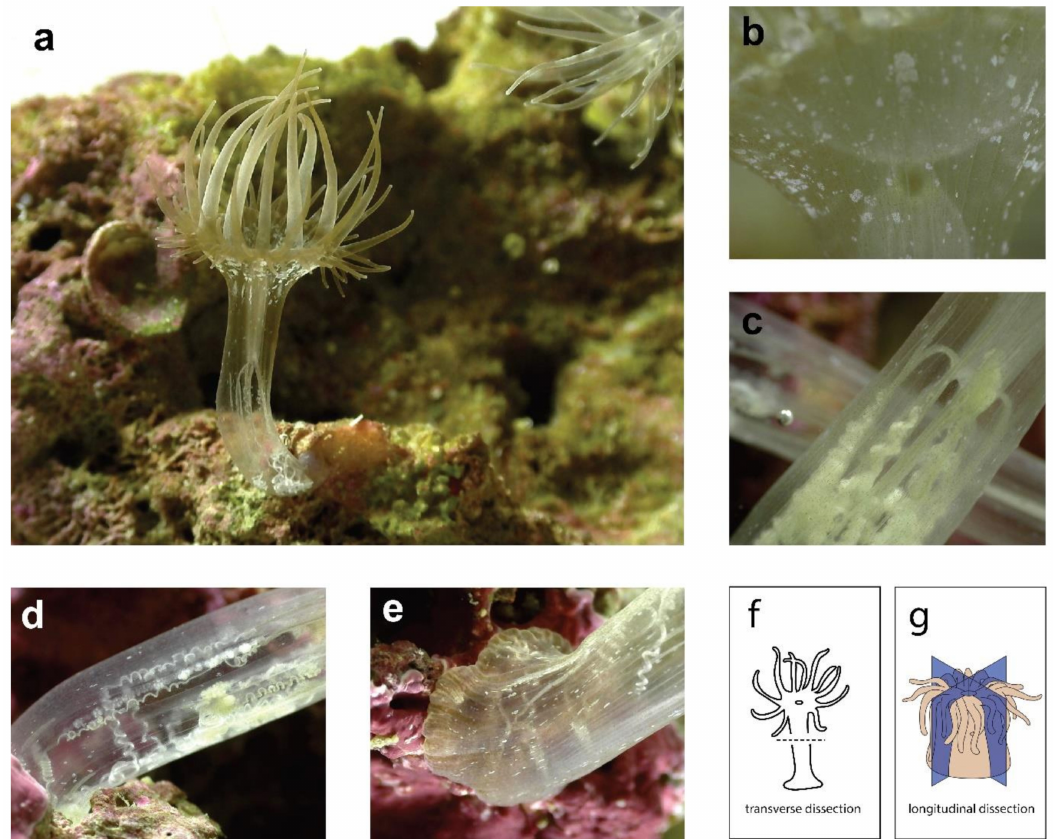
Figure 2. Multiple images of a bleached E. diaphana individual, showing the internal tissue organization. ( a ) an E. diaphana individual attached to a coral rock, in an upright position; ( b ) a portion of the oral disc showing where the mouth meets the pharynx; ( c ) the middle of the body column where the mesentery filaments are attached to the end of the pharynx (enterostome); ( d ) lower half of the body column, showing mesenteries and acontia; ( e ) lowest portion of body column and pedal disc ( f ) diagram of sea anemone showing transverse dissection plane; ( g ) diagram of sea anemone showing longitudinal dissection planes, reproduced with permission from [78]. See Supplementary File S1 for image copyrights and